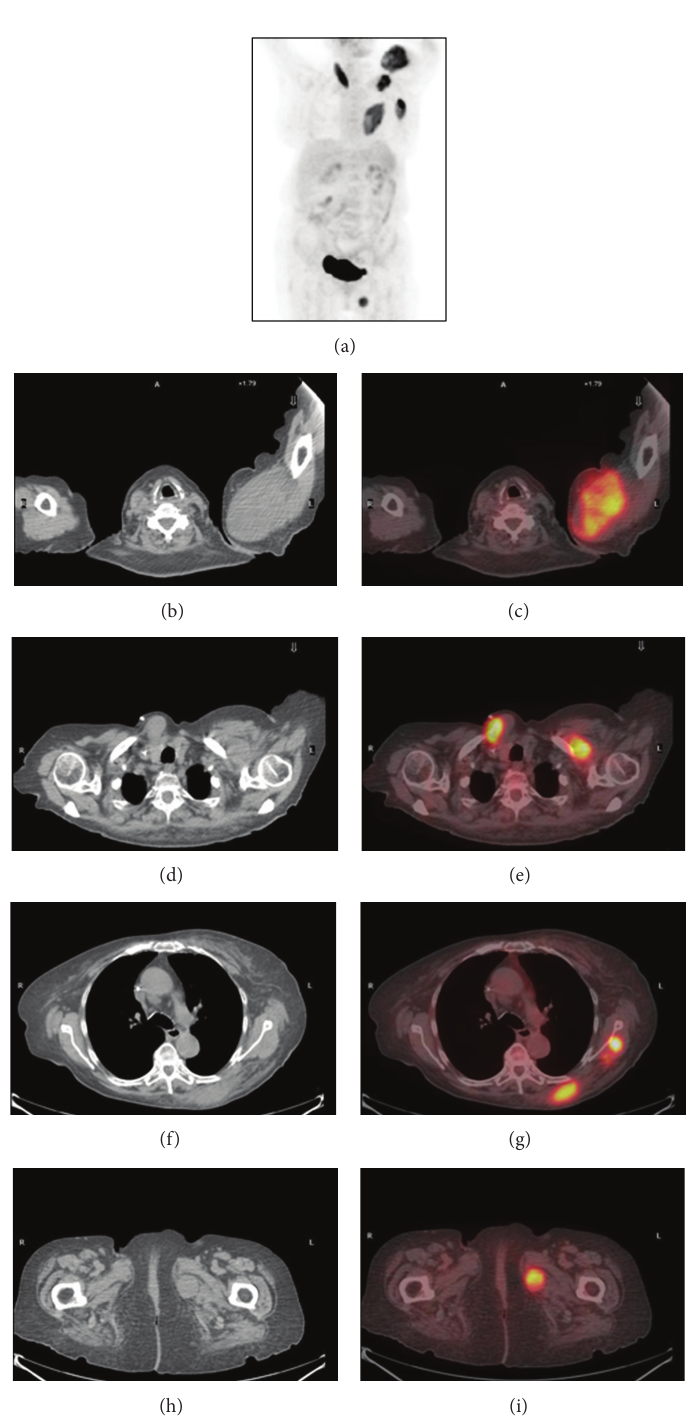
Figure 1: (a) Whole body PET scan showing multiple muscle metastases. ((b)–(i)) CT ((b), (d), (f), and (h)) and combined CT/PET ((c), (e), (g), and (i)) scan images showing multiple metastases in deltoid ((b) and (c)), sternocleidomastoid ((d) and (e)), trapezius and infraspinatus ((f) and (g)), and adductor magnus ((h) and (i)) muscles.